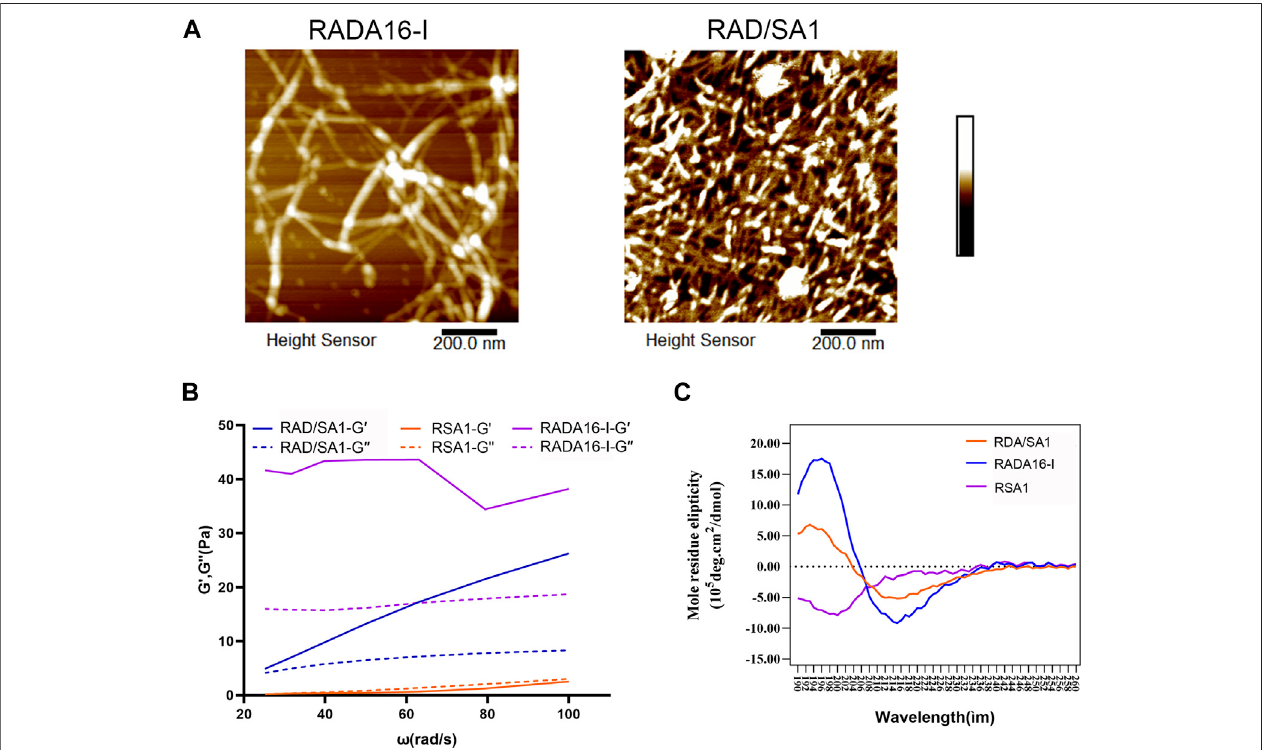
FIGURE 2 | (A) The AFM results showed that nano fi ber formation occurred in of all of the solutions of the self-assembling peptides. (B) Results of the oscillation frequencysweepdataon1%(w/v)ofthedesignerself-assemblingpeptideswithDMEMat37 ° C.Atypicalgel-likebehaviorwasevidentasthestoragemodulusvaluesof theRAD16-IandRAD/SA1werehigherthanthelossmodulusvaluesintherangeoftheshearratefrequencies. (C) Thefunctionalizedself-assemblingpolypeptidemixed with RADA16-I in equal proportions resulted in a typical β -sheet